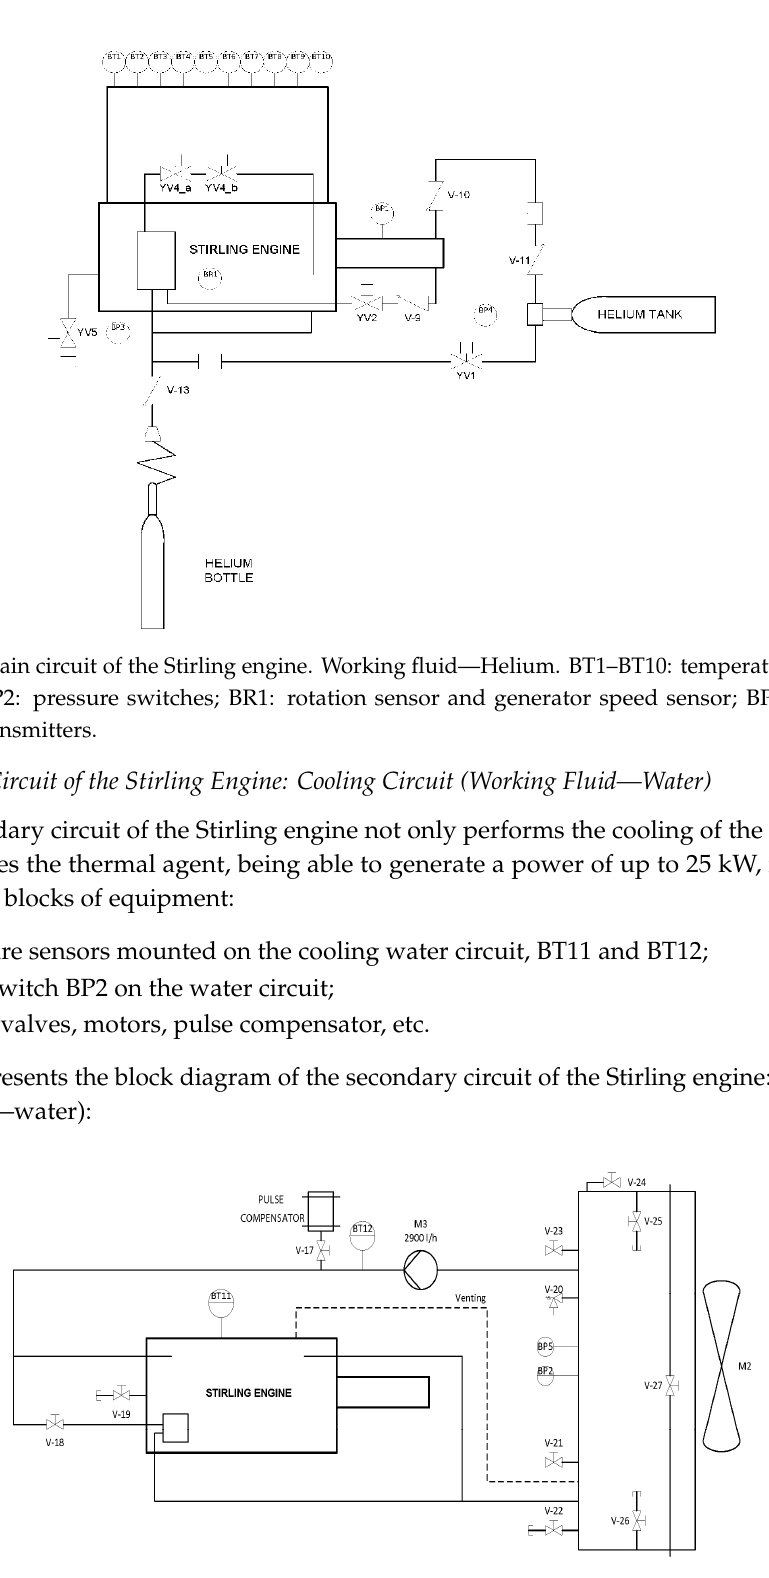
Figure 8. Secondary circuit of the Stirling engine, water-cooling. BT11 and BT12: temperature sensors.